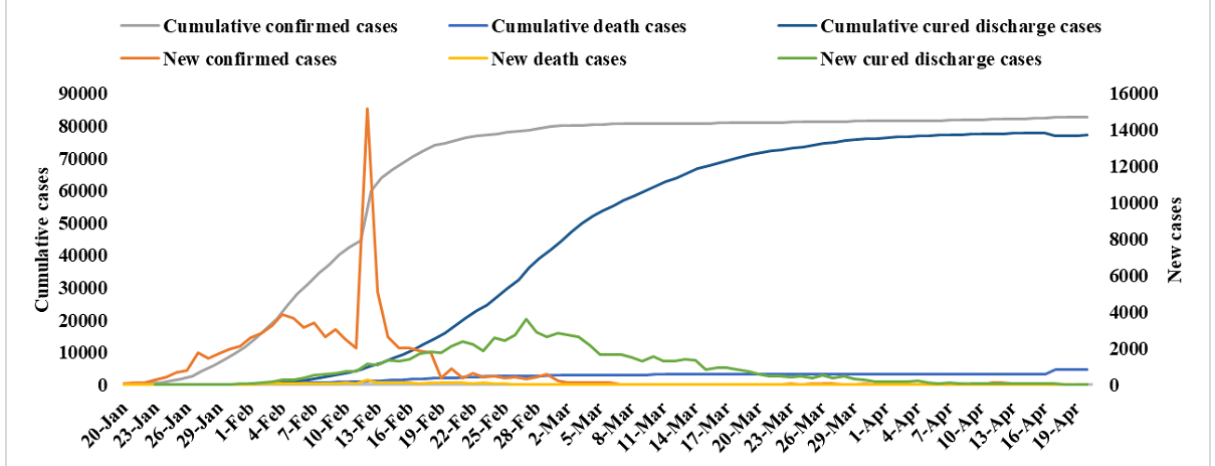
Figure 1. The epidemic characteristics of COVID-19 in China from January 20 to April 20, 2020.